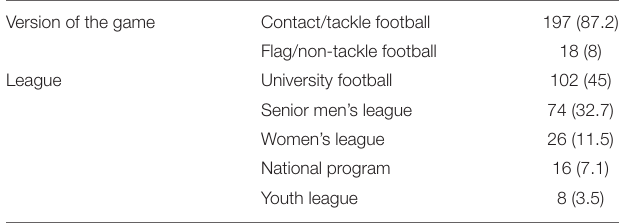
TABLE 1 | Player profile. Version of the